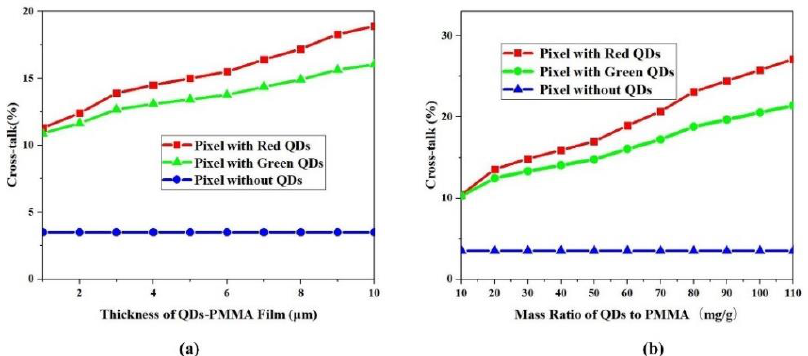
Figure 7. Simulated color crosstalk ratio as a function of a QDs film's ( a ) thickness; and ( b ) the mass ratio of QDs to PMMA.